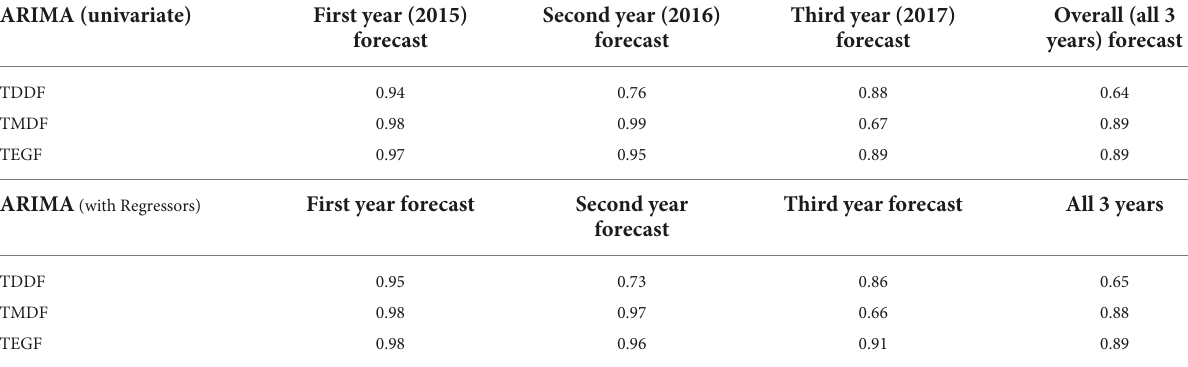
TABLE 2 Correlation [coefficient of determination ( R 2 )] between original and forecasted monthly fire values from 2015 to 2017. ARIMA